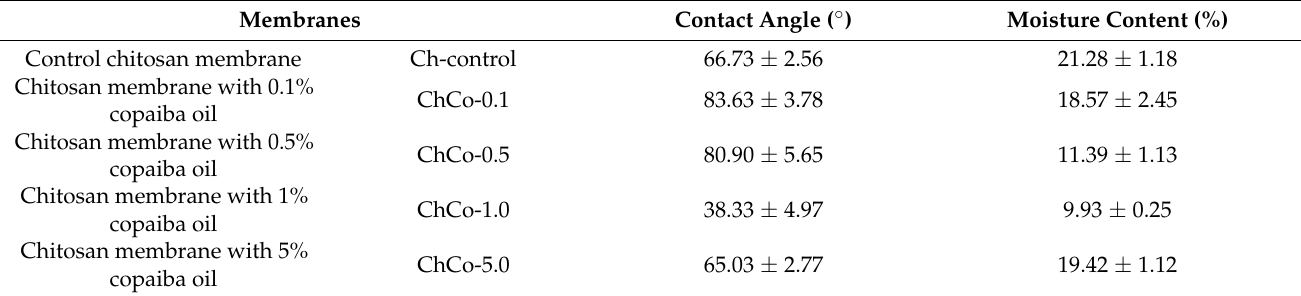
Table 5. Measurements of the contact angle with water and moisture content of the developed